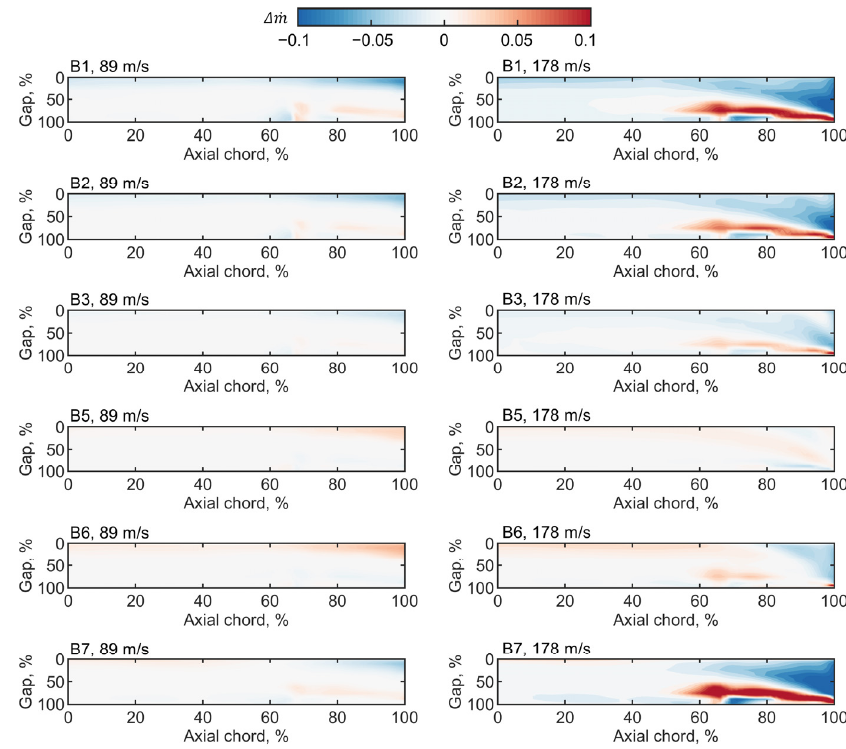
Figure 14. Density flow difference at different pitch locations.